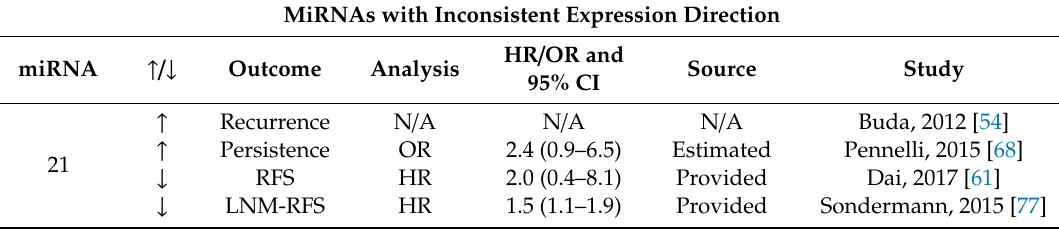
Table 4. Characteristics of the miRNAs with inconsistent